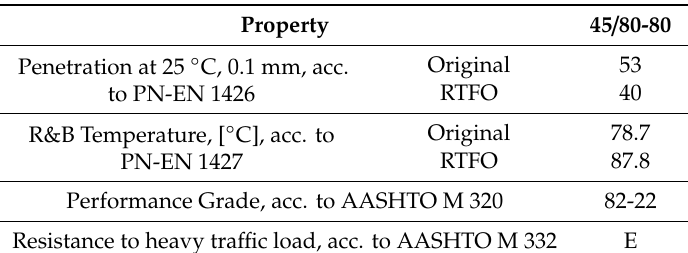
Table 1. Properties of SBS-highly modified bitumen.